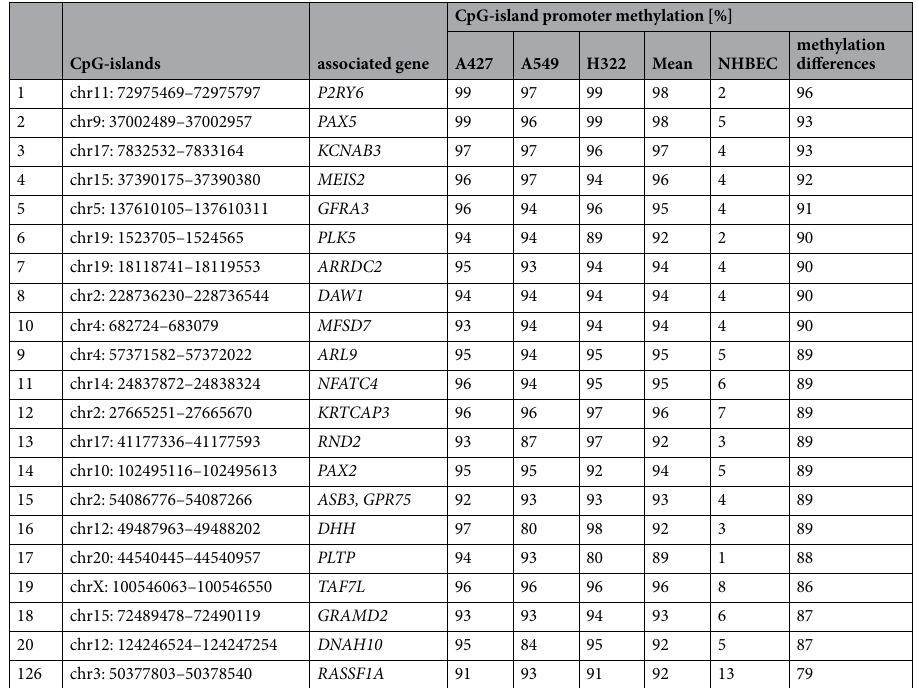
Table 1. Top 20 lung cancer-specific hypermethylated CGI-associated